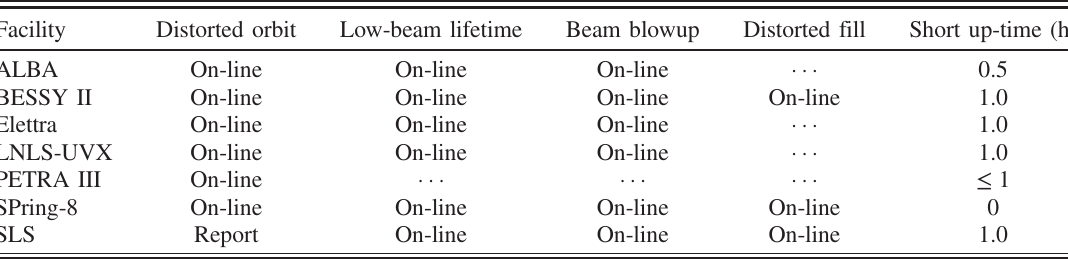
TABLE III. Secondary failure modes at different